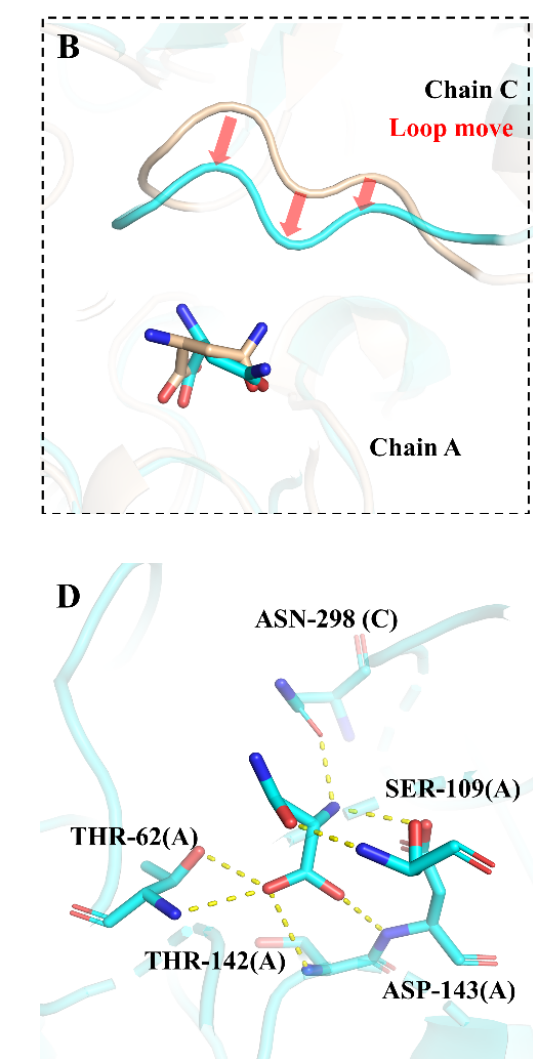
Figure 6. The binding patterns of wild-type and mutant ILRAC complexes with L-asparagine after 100 ns MD. The orange cartoon represents wild-type and the blue cartoon represents mutant ILRAC. ( A ) The overlay of wild-type and ILRAC. The sphere indicates the substrate L-asparagine. ( B ) Alterations in the substrate binding site. ( C ) The interaction of wild-type with L-asparagine. ( D ) The interaction of mutant ILRAC with L-asparagine. The yellow dashed line represents the hydrogen bond.